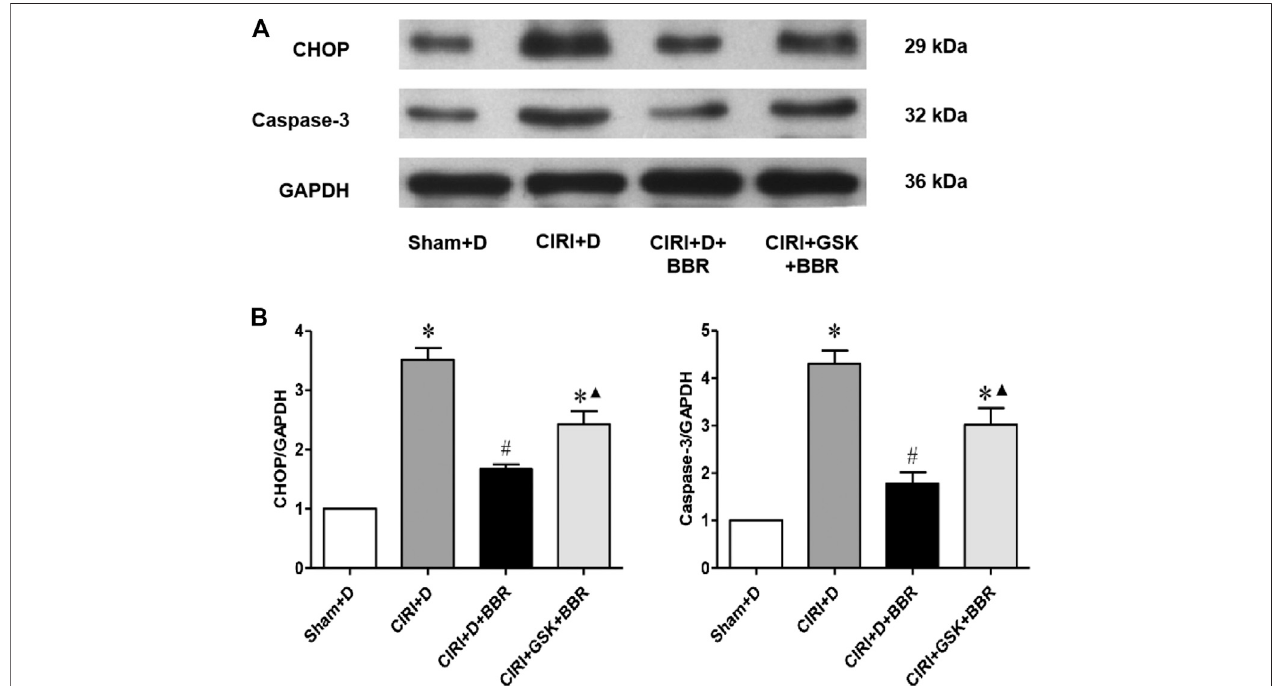
FIGURE 7 | BBR attenuates neuronal apoptosis via the CNPY2-PERK pathway in cortical ischemic penumbra. The CNPY2-PERK apoptotic signaling proteins CHOP (A) and cleaved Caspase-3 (B) from cortical ischemic penumbra were determined by Western blot. The results were normalized to the percentage of GAPDH expression. (B) ,BargraphshowingthestatisticalcomparisonofCHOPandcleavedCaspase-3proteinlevelsacrossgroups. n (cid:2) 6.Dataareshownasthemean ± SEM. * p < 0.05 compared with the Sham + D group; # p < 0.05 compared with the CIRI group; ▲ p < 0.05 compared with the CIRI + D + BBR